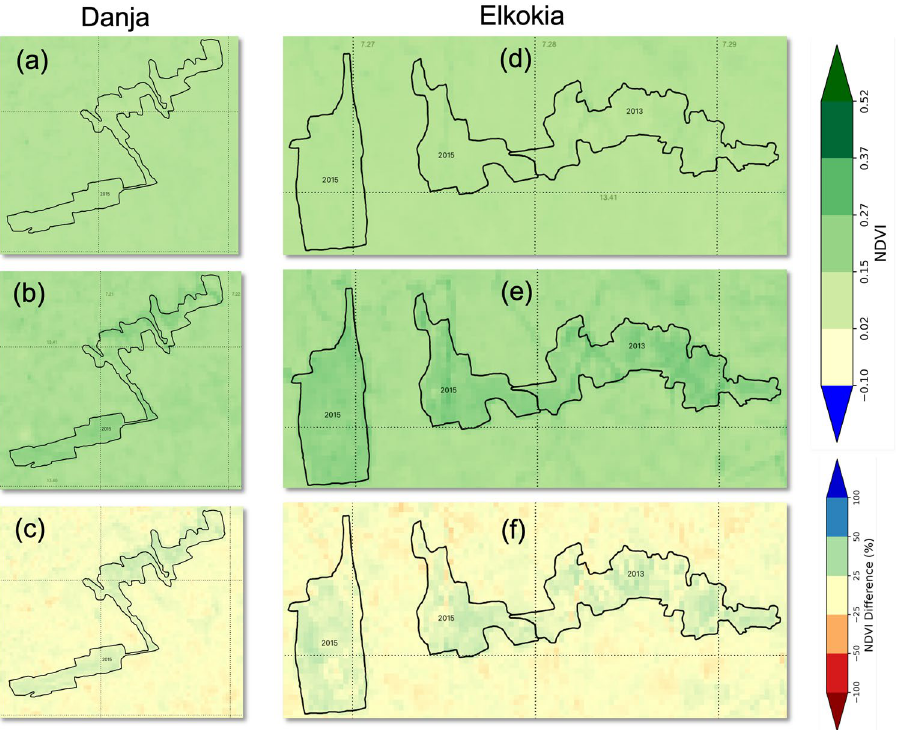
Figure 1. NDVI map for two locations Danja ( a - c ) and Elkokia ( d - f ) for the month of Jun before [year 2013 ( a ) and ( d )] and after [year 2019 ( b ) and ( e )] interventions. The bottom panel ( c and f ) shows the percent difference in NDVI values from Jun 2013 to Jun 2019.